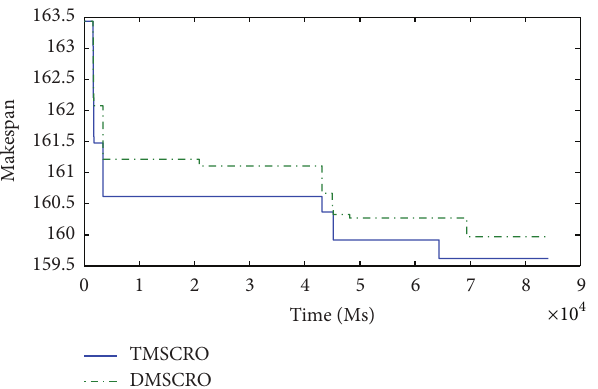
Figure 24: The convergence trace for the molecular dynamics code; ccr = 1 ; the number of processors is 16.